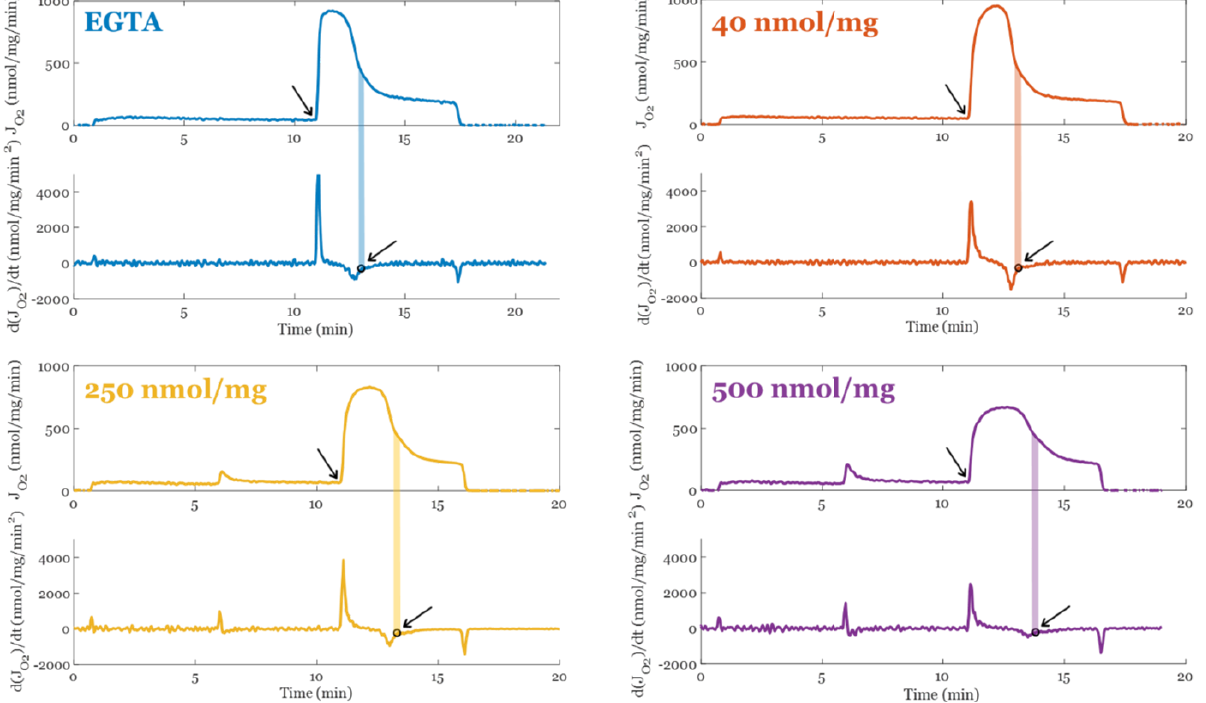
Figure 3. Method used to calculate the duration of oxidative phosphorylation. The transition is marked with an open circle and a shaded area for each condition that was used to estimate the point the majority of the O 2 flux switches from oxphos using the original ADP bolus to futile ATP cycling. This ATP cycling occurs when the rate of mitochondrial ATP efflux matches the ATP hydrolysis rate from extramitochondrial ATPase contaminants. All mitochondrial preparations when Mg 2+ is present contain these contaminants. The arrows point to the start and end of oxphos for each condition.